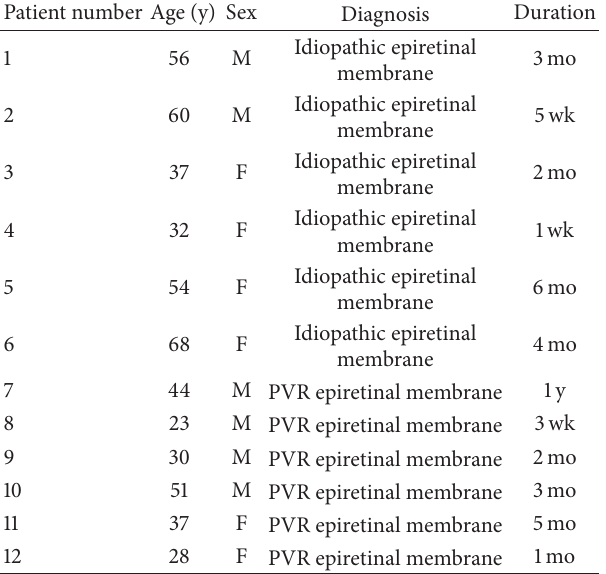
Table 1: Clinical characteristics for individual proliferative retinal